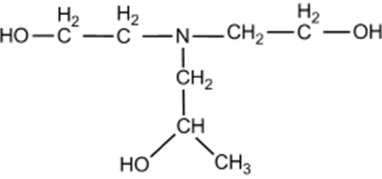
Figure 2. Molecular structure of diethanol-isopropanolamine (DEIPA).